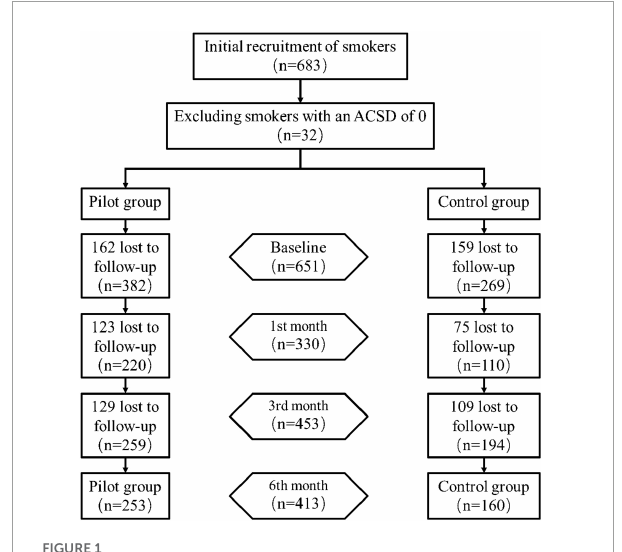
FIGURE1 Baseline and follow-up of smokers included in the